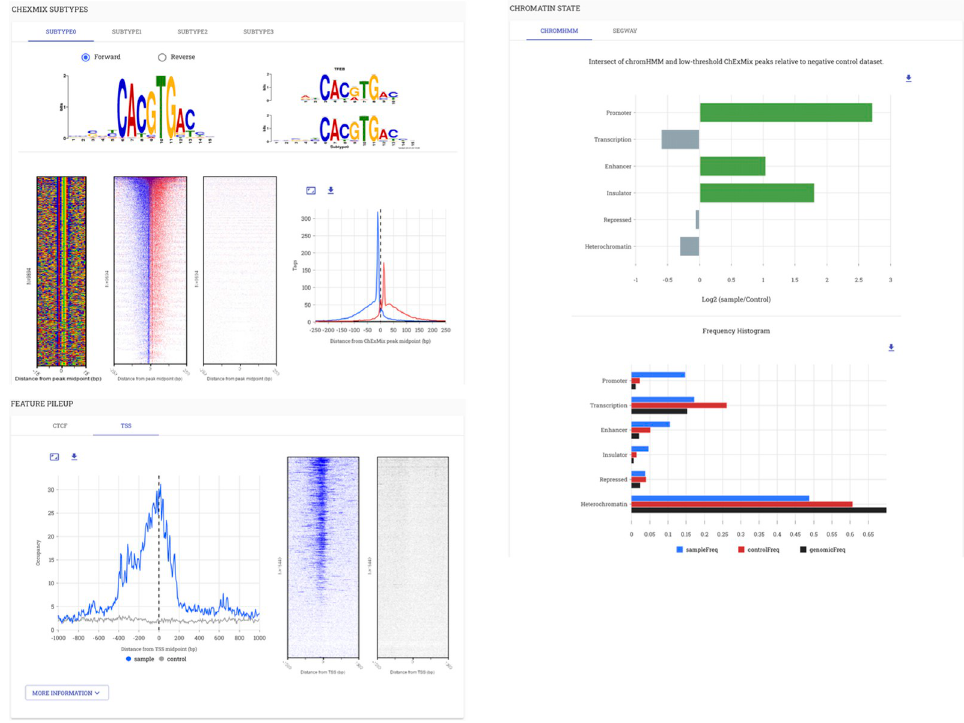
Fig 5. Application of STENCIL in the Yeast Epigenome Project. A comprehensive map of protein binding in S . cerevisiae required the development of a Galaxy workflow to both generate quality control metrics as well as provide baseline biological insight. Full analysis with high-resolution figures is available at http://www.yeastepigenome.org/yep/